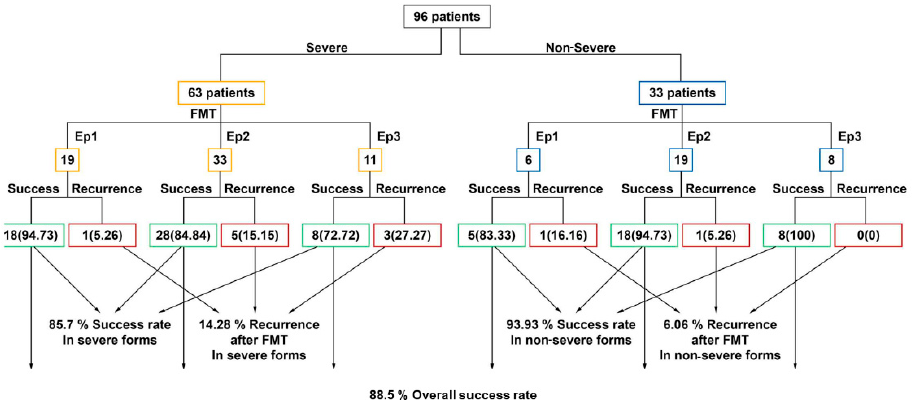
Figure 2. FMT success and recurrence rates, numbers (percentages).